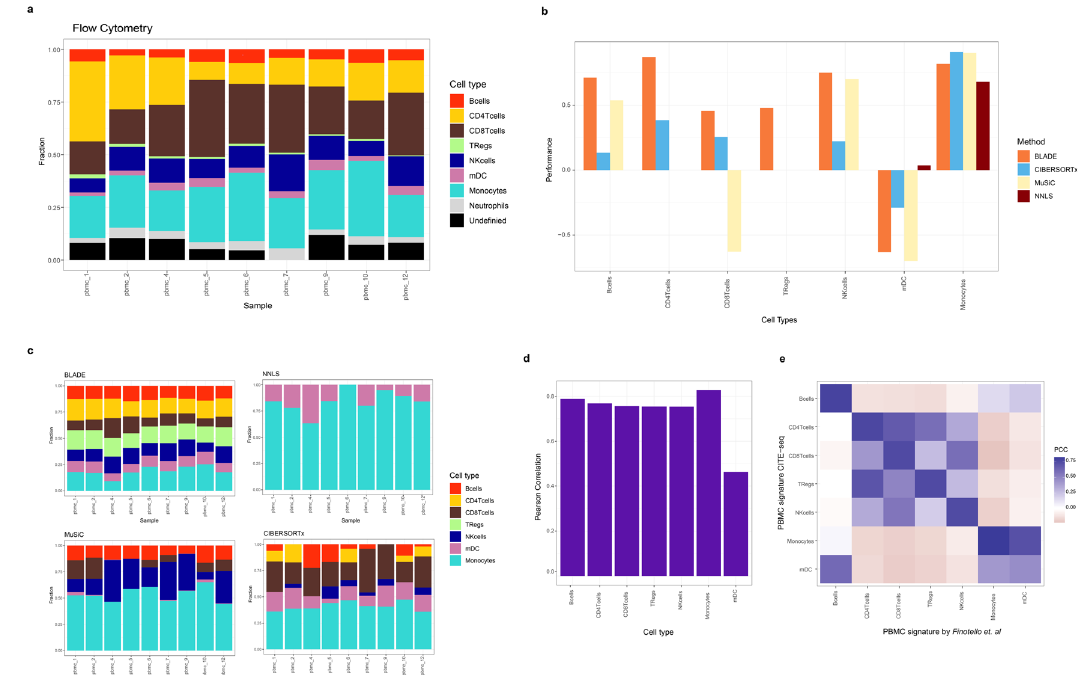
Fig. 6 Performance evaluation of BLADE using PBMC bulk RNA-seq data with incomplete prior knowledge. a Cell types fractions ( y -axis) determined by fl ow cytometry in nine samples ( x -axis). All cell types* have a color associated as shown in the legend. b Performances of BLADE (orange), CIBERSORTx (blue), NNLS (dark red) and MuSiC (light yellow), measured by Pearson correlation ( y -axis) of the estimated sample-speci fi c cell type ( x -axis) fractions with those determined by fl ow cytometry. c Estimated cell fractions ( y -axis) per sample ( x -axis) by BLADE (top-left), NNLS (top-right), MuSiC (bottom- left) and CIBERSORTx (bottom-right). d , e Pearson correlation ( y -axis in d and color gradient in e ) of the signature per pair of cell types determined by Finotello et al. and two PBMC scRNA-seq data used in this study. *(TRegs: regulatory T cells; NKcells: natural killer cells; mDC: myeloid dendritic